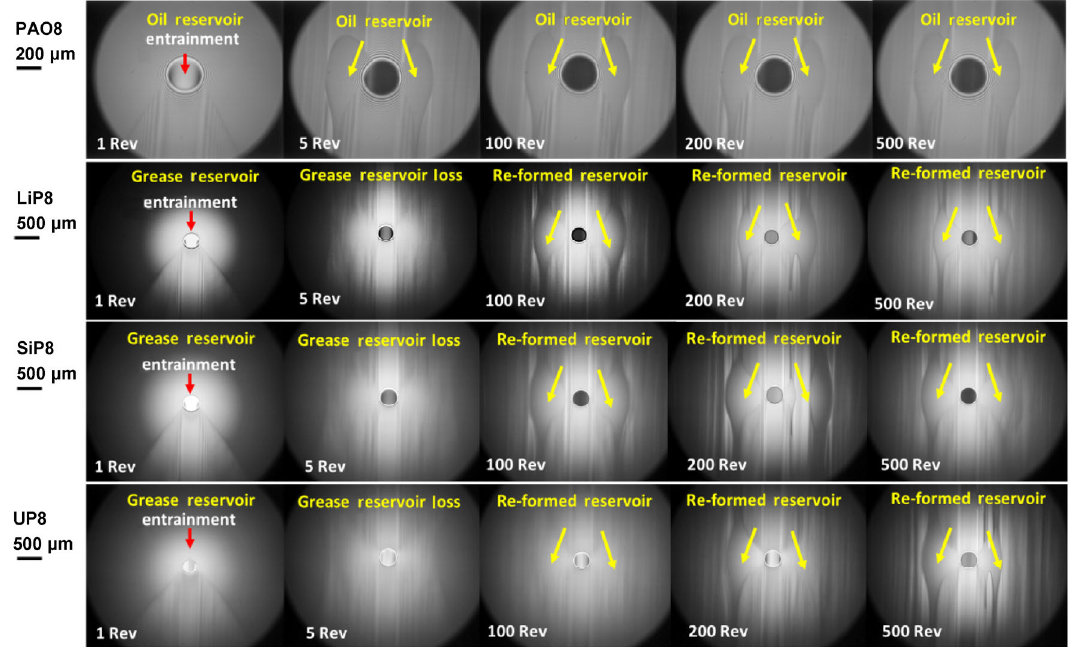
Fig. 2 Dynamic reservoir formed by different lubricants. All these photos were taken at 250 mm/s after rolling for 1, 5, 100, 200, and 500 revolutions,